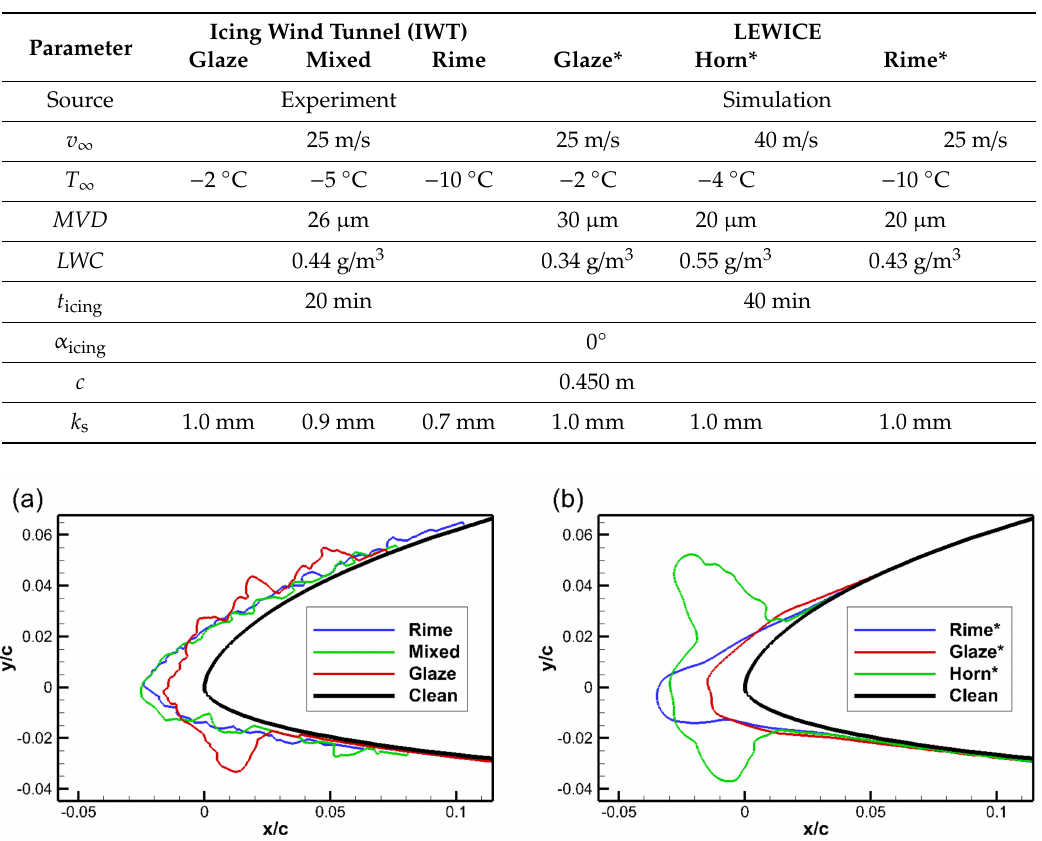
Table 2. Overview of icing conditions used for the generation of the experimental icing wind tunnel (IWT) and LEWICE ice shapes.